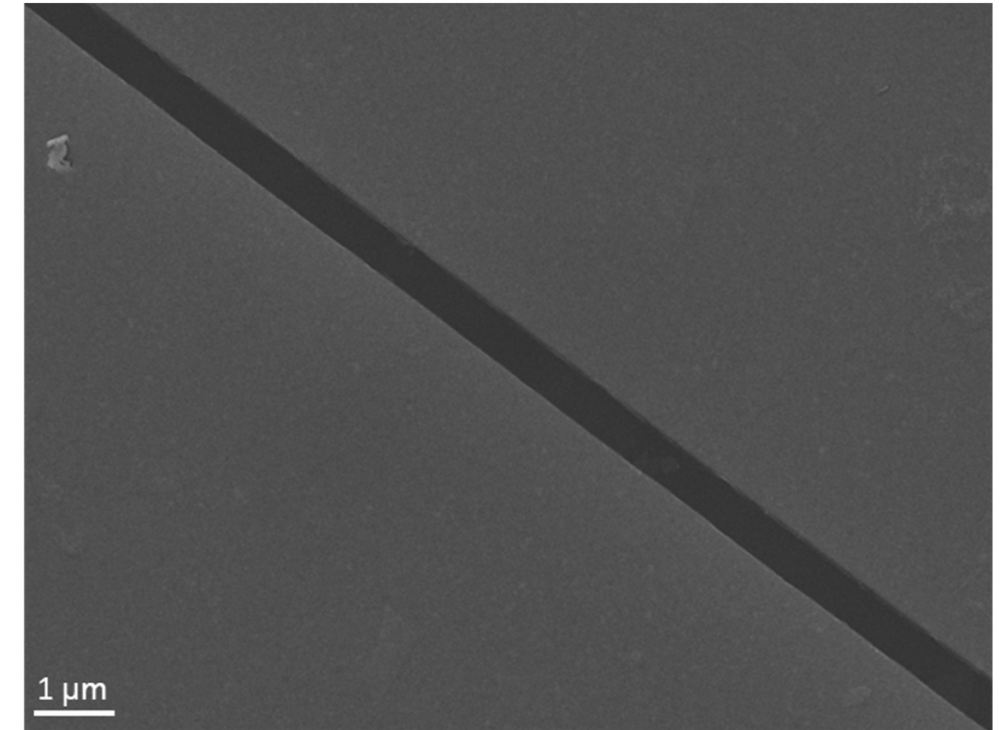
Figure 6. SEM image of the channel fabricated by nanofiber masks. The performance of electrochemically exfoliated In 2 Se 3 single-flake and thin-film FETs were comparable to those made from other methods in terms of mobilities and on/off ratios (Table 1) [25–29]. A comprehensive comparison is provided in Table 1. The electrochemically exfoliated In 2 Se 3 single-flake FET performance was superior to some mechanically exfoliated In 2 Se 3 flake FETs [27]. The electron mobilities and on/off ratios of the LbL-assembled In 2 Se 3 thin film was close to those of the spin-coated In 2 Se 3 thin films and CVD-grown In 2 Se 3 thin films [12,28]. The outstanding device performances of both single flakes and thin films are attributed to the high-quality nanosheets with uniform sizes and thicknesses prepared by electrochemical